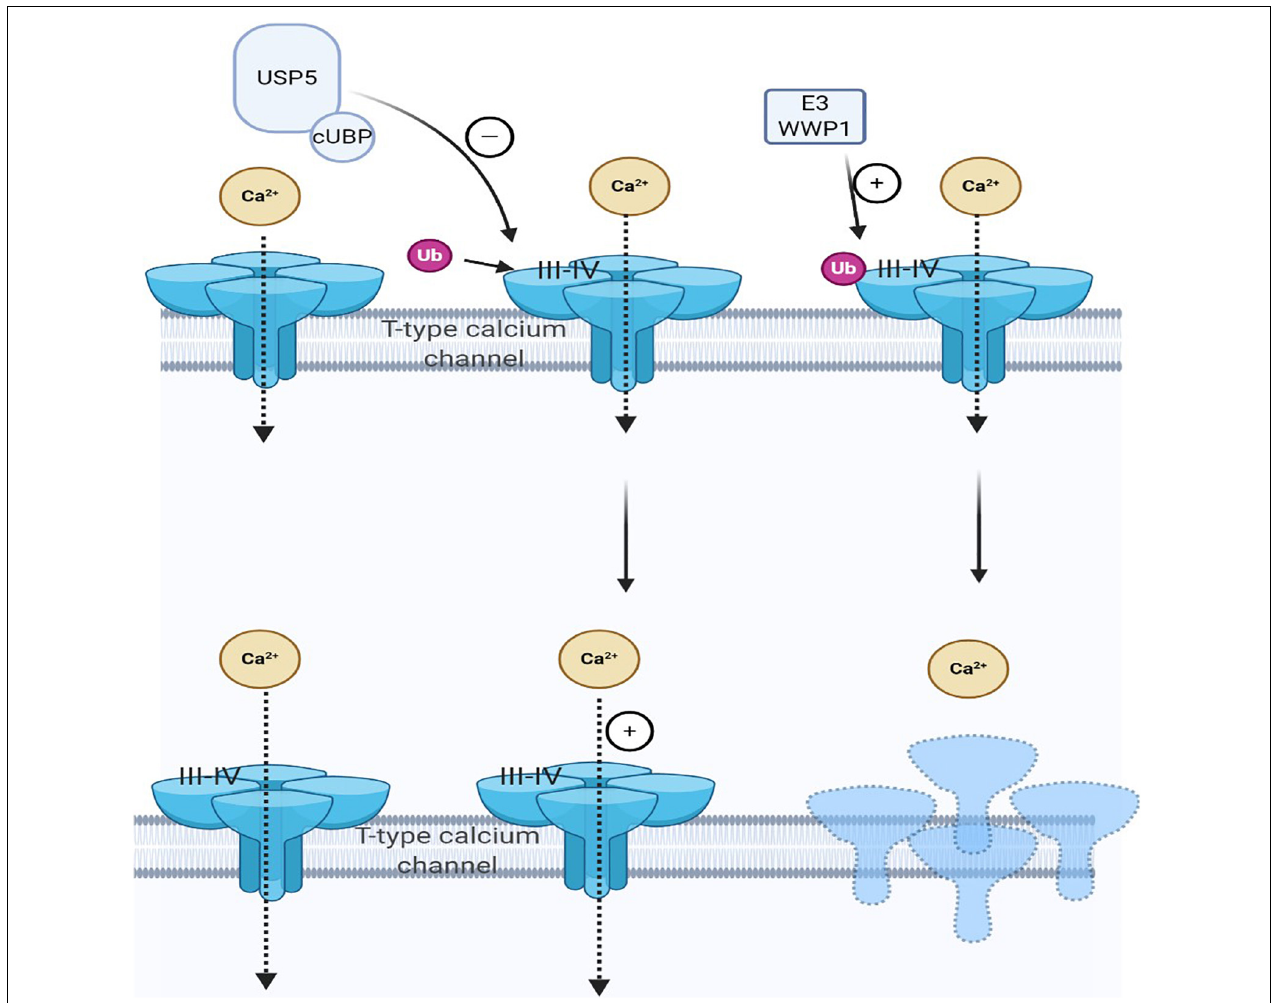
FIGURE 2 | Cav3.2 channel ubiquitination status is regulated by the interaction of E3 ligase and ubiquitin-specific protease 5 (USP5). The ubiquitination state of Cav3.2 channel in the pain pathway is regulated by the interaction of USP5 and HECT E3 ligase HECT E3 ligase E3 ubiquitin-protein ligase 1 (WWP1), which can regulate the stability of the calcium channel protein in the plasma membrane. When pain occurs, USP5 is upregulated and its cUBP domain interacts with the III–IV junction of Cav3.2 T-type calcium channels. This can reduce the ubiquitination of Cav3.2 channels and upregulate Cav3.2 channels, making them more stable on the cell surface. WWP1 also binds to intracellular regions III–IV in the Cav3.2 t-channel junction region and modifies specific lysine residues in this